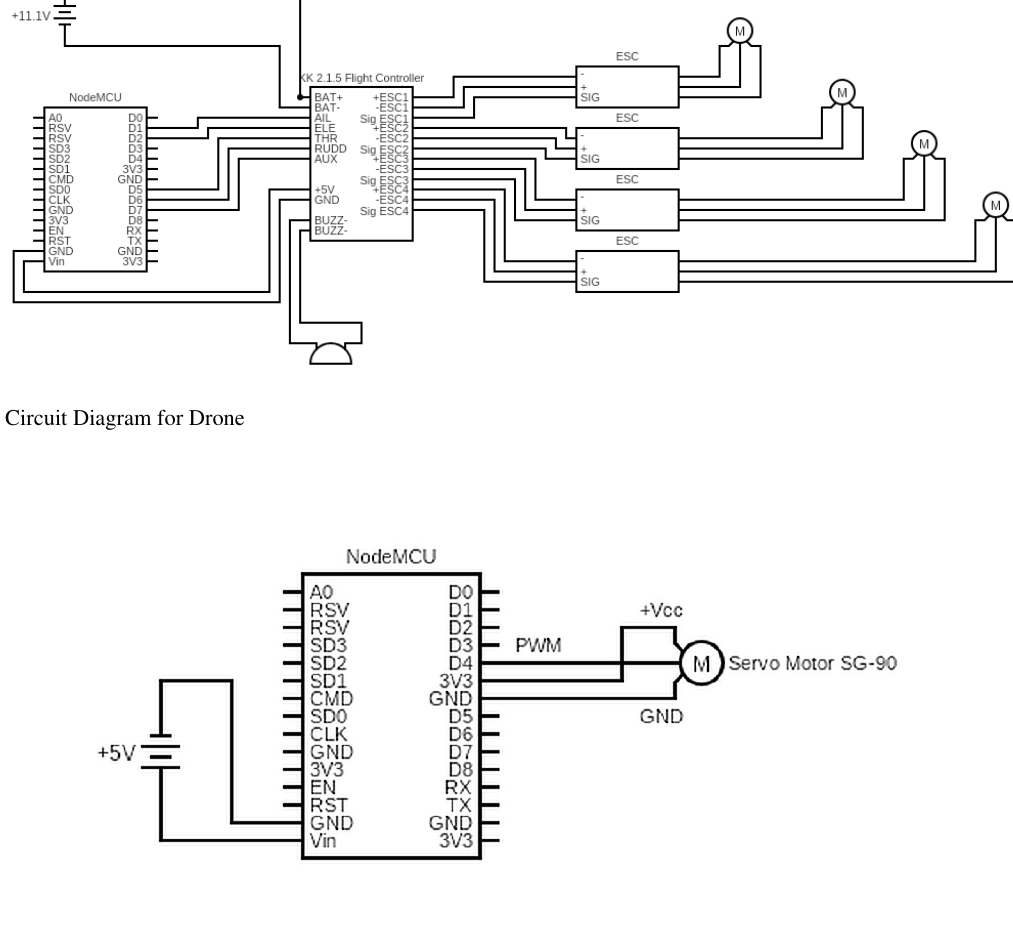
Figure 4. Circuit Diagram for Locking